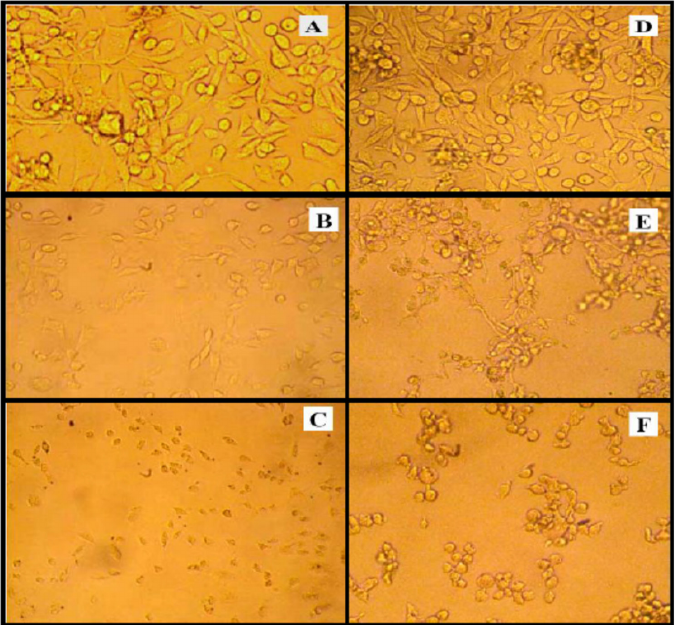
Fig. 1. The cytopathic action of S. dysenteries filtrate supernatant on mammalian cell lines were A : untreated RD cells B : RD cells treated with non-heated filtrate supernatant for 18 hr. the cells shown shrinking, detaching and rounded in shape C : degradation, lyses and most treated RD cells were death after treated with heated supernatant at 100°C after 120 hr. D : untreated L20B cells E : L20B cells shown shrinking, detaching, accumulation and rounded in shape after treated with non-heated filtrate supernatant for 18 hr F : death most treated L20B cells with heated supernatant at 100°C after 120